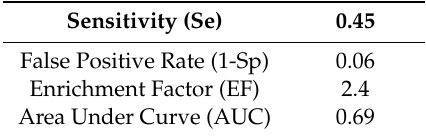
Table 2. ROC performance of the examined pharmacophore model.